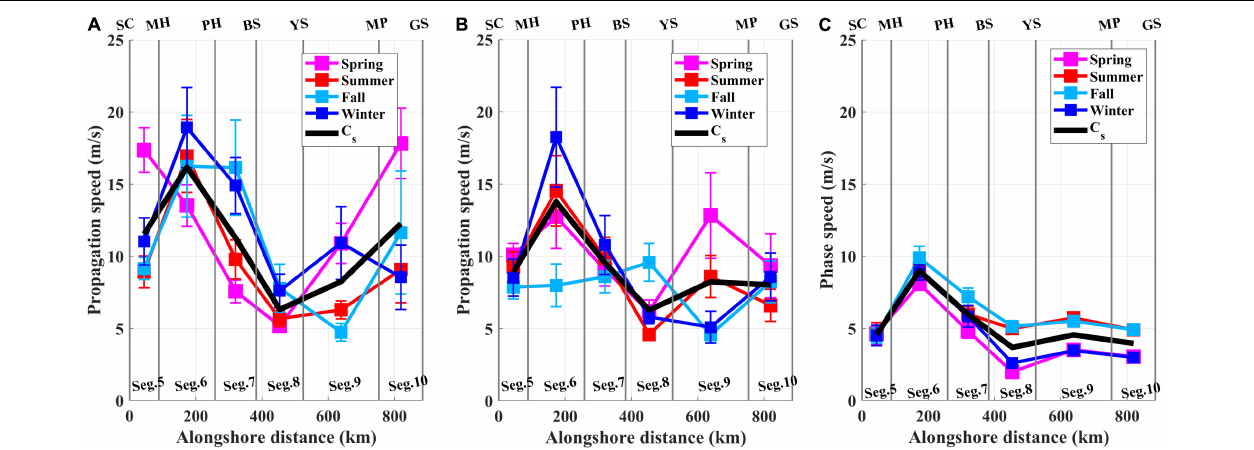
FIGURE 5 | Segment-mean of the observed propagation speed (OPS) for each season ( (cid:83) C , y -axis) in m/s for (A) all periods, (B) only periods of weak subtidal fluctuations in atmospheric pressure (OPS-LP), and (C) the segment-mean of the modeled phase speed (MPS) of the mode-1 CTW ( c 1 ) for each season ( (cid:83) C , y -axis) in m/s as a function of the alongshore distance in km ( x -axis) for spring (pink squares and lines), summer (red squares and lines), fall (sky blue squares and lines), and winter (blue squares and lines), respectively. The season-mean of (cid:83) C ( C s ) for the OPS and MPS in each segment is denoted by black solid lines. Vertical bars represent the uncertainties of the (cid:83) C estimation derived from the interannual spread.